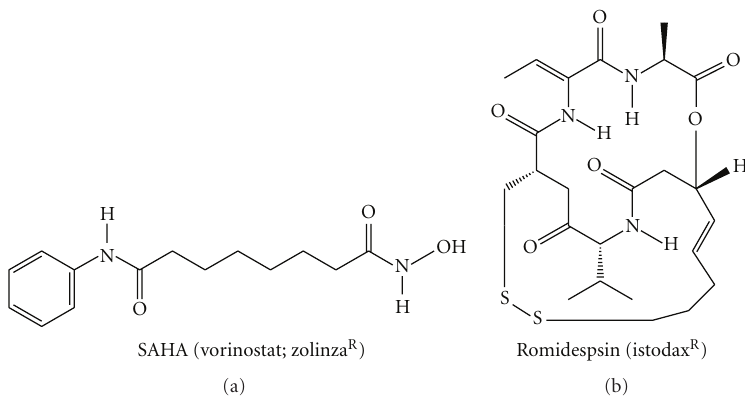
Figure 6: FDA-approved HDAC